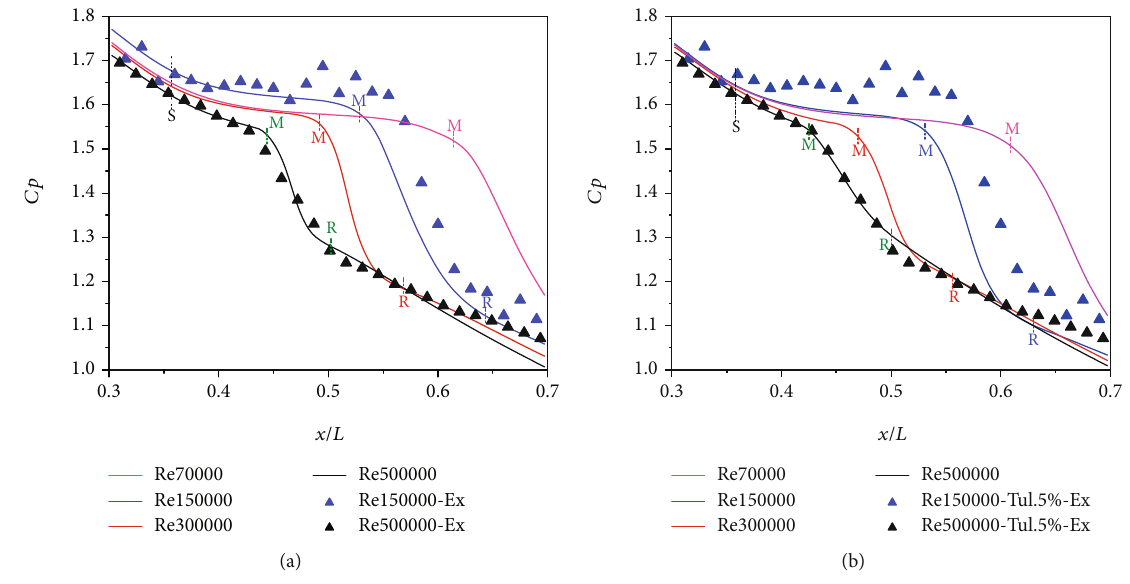
fi xed (a) Tu1.5% and (b) Tu5.0%. Figure 9: C p comparison with